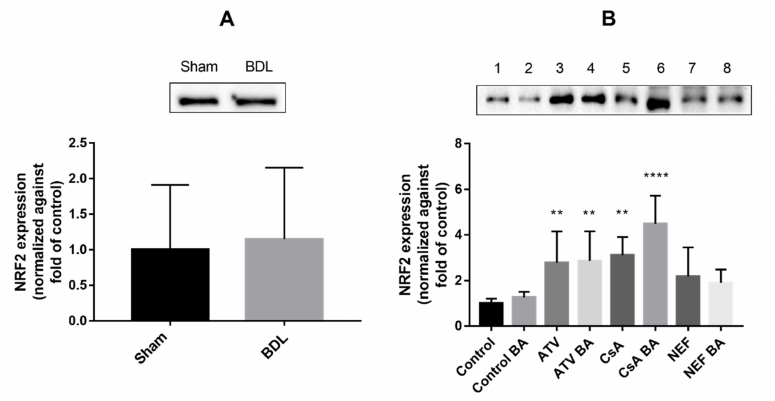
Figure 4. Nrf2 protein expression in cholestasis. Semi-quantitative immunoblot analysis of Nrf2 protein in livers of cholestatic mice ( A ) and in human hepatoma HepaRG cells cultured in cholestatic conditions ( B ) was performed. Signals of Nrf2 were normalized against total protein loading and expressed as relative alterations compared to sham-operated animals or to control samples, respectively. ( A ) Liver sections were obtained from male mice following bile duct ligation (BDL) for 20 days. Data were processed by a parametric student t-test with Welch’s correction. Data are expressed as means +/ − SD compared to sham-operated animals (Sham n = 12; BDL n = 18) (N = 1). ( B ) Human hepatoma HepaRG cells were exposed to cholestatic drugs either in the absence or presence of a 50 × concentrated mixture of bile acids (BA) for 72 h and compared to untreated human hepatoma HepaRG cells, indicated in the figure as control. The di ff erent experimental conditions are presented in the figure as: 1 = control; 2 = control BA; 3 = atazanavir (ATV); 4 = ATV BA; 5 = cyclosporine A (CsA); 6 = CsA BA; 7 = nefazodone (NEF); 8 = NEF BA. Data were processed by a parametric one-way ANOVA followed by post hoc tests with Dunnett’s correction. Data are expressed as means +/ − SD with ** p ≤ 0.01 and **** p ≤ 0.0001 compared to control samples (control n = 3; control BA n = 3; ATV n = 3; ATV BA n = 3; CsA n = 3; CsA BA n = 3; NEF n = 3; NEF BA n = 3) (N =